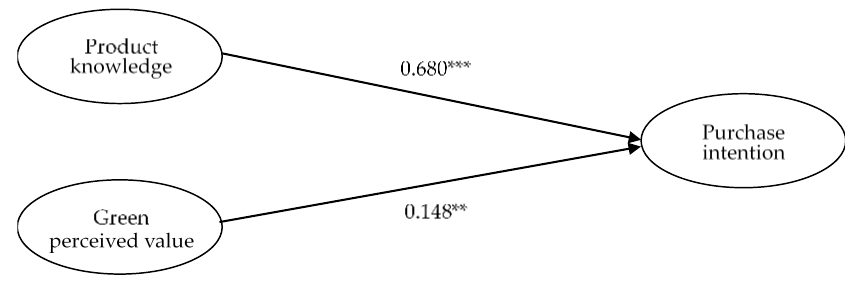
Table 3. Means, standard deviations, and correlations of constructs.